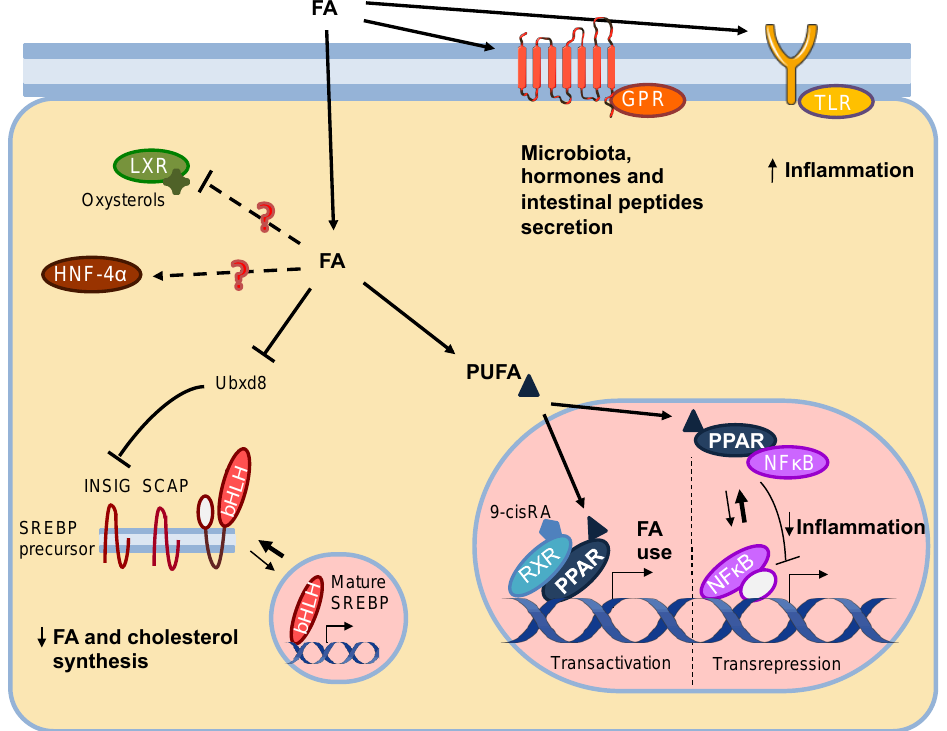
Figure 1. General mechanisms of transcriptional regulation by fatty acids (FA). Fatty acids bind to the TLR4 or GPR membrane receptors, inducing inflammation or hormone secretion, respectively. They can also bind to nuclear receptors, although their interaction with LXR and HNF-4 α is not entirely clear. In contrast, PUFA binding to PPAR can induce transactivation from the formation of the active heterodimer PPAR-RXR, which promotes different pathways of fatty acid use, or transrepression, recruiting NF- κ B and preventing its action on its target genes and thus reducing inflammation. Regarding transcription factor SREBP, its maturation is repressed by fatty acids through inhibition of Ubxd8 and promoting the sequestration of SREBP by SCAP and INSIG, among other mechanisms. This figure was created with Servier Medical Art (https://smart.servier.com/, accessed on 20 August 2020) under a creative commons license (https://creativecommons.